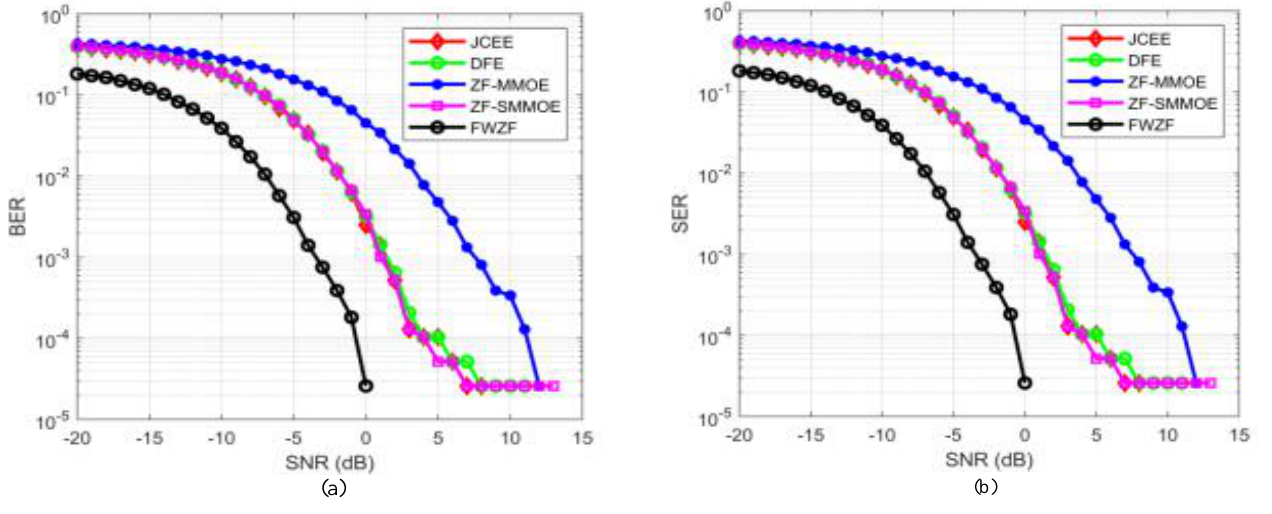
Fig. 4. Comparative analysis using antenna=5 in Rayleigh channel, (a) BER, (b) SER